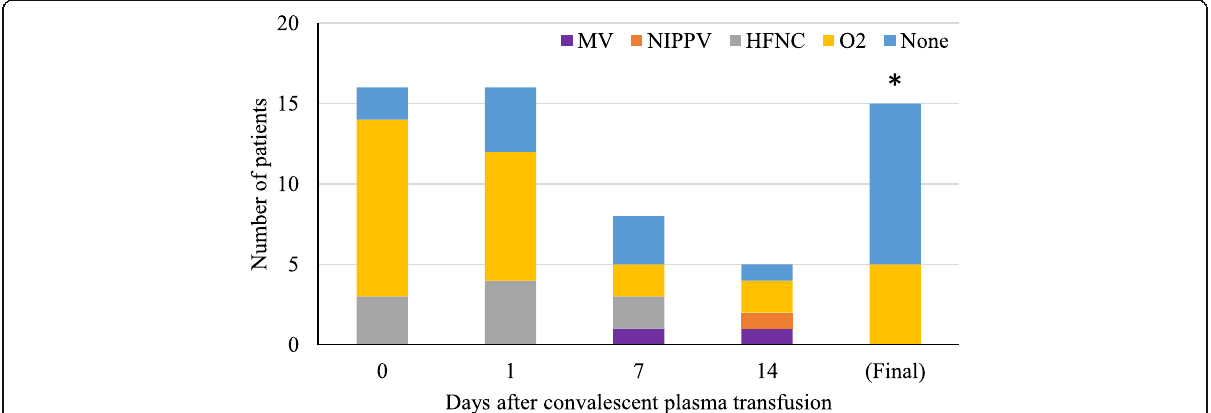
Fig. 2 Legend: Inpatient respiratory support type by hospital day among COVID-19 patients with severe disease receiving convalescent plasma (n = 16). The asterisk (*) marks that two patients were excluded from the tally because their final respiratory status was not known. At the time of last follow-up, one was on mechanical ventilation and one was on low-flow nasal